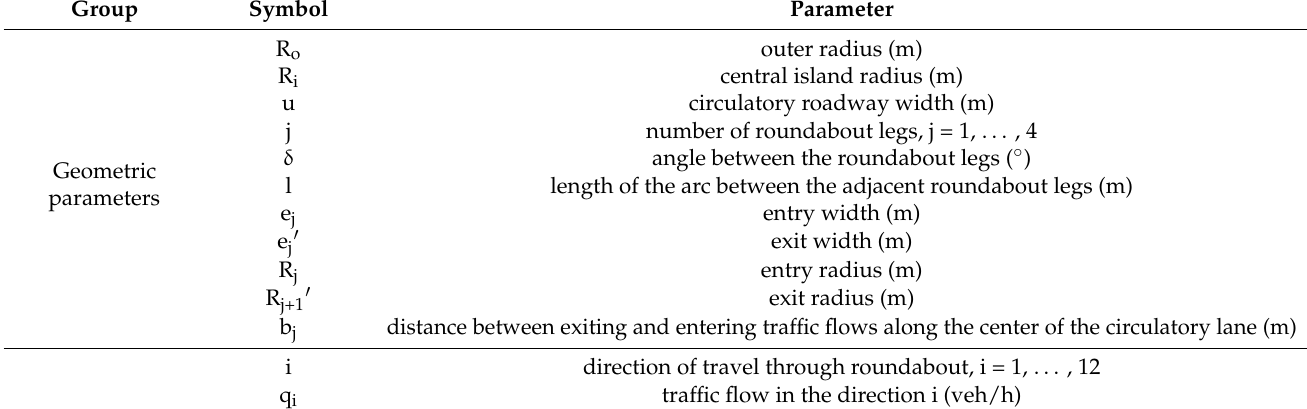
Table 1. List of symbols used in the